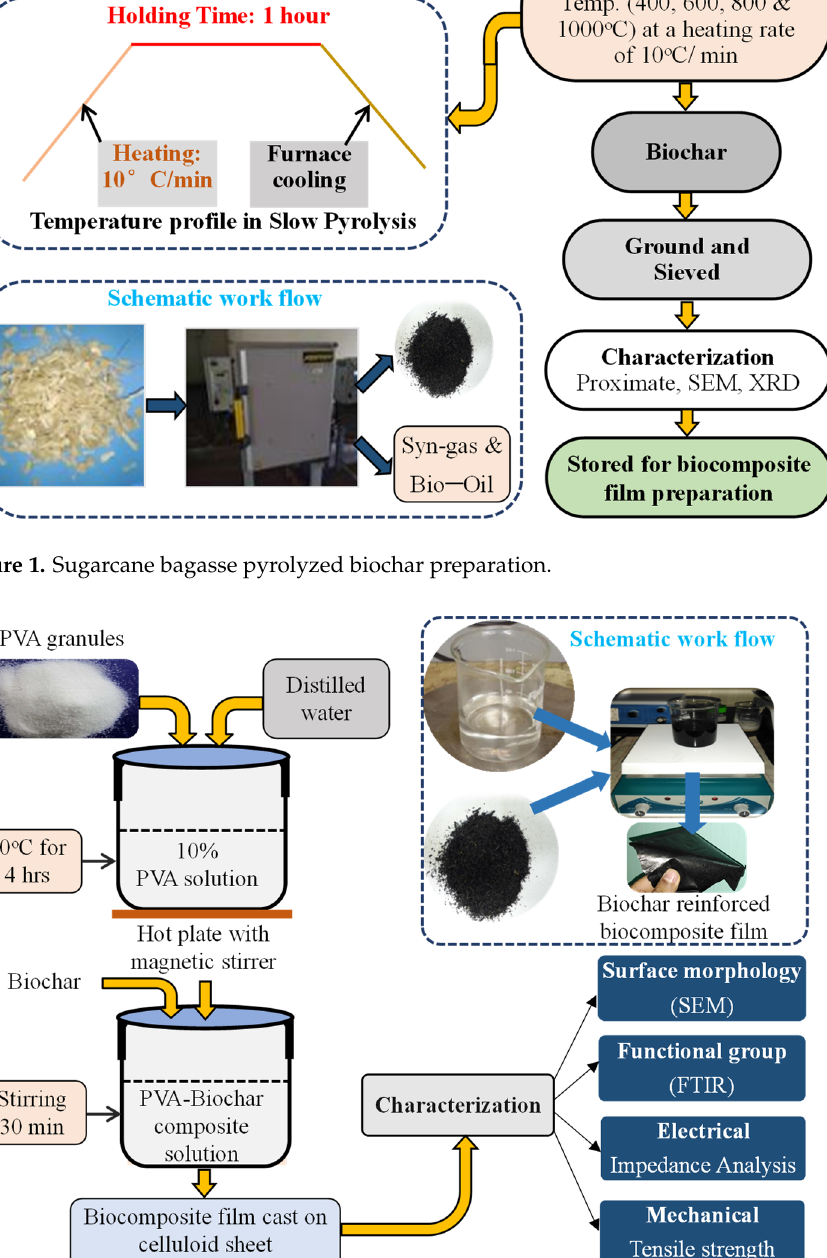
Figure 2. Preparation of biocomposite films with sugarcane bagasse pyrolyzed biochar.